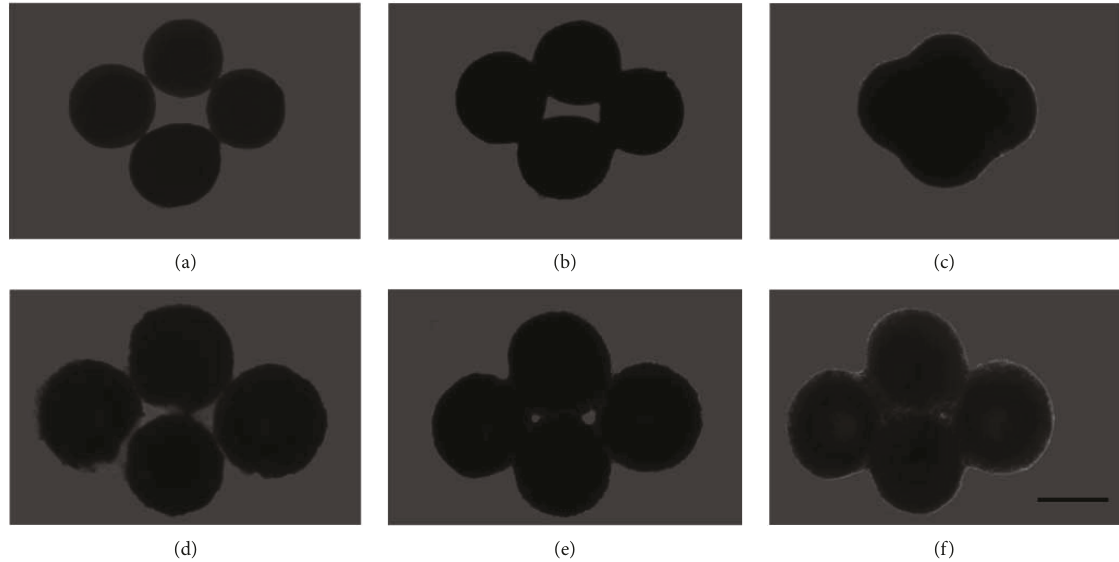
Figure 7: The CPC spheroids retained their fusion capacity even after spontaneous chondrogenesis. The CPC spheroids maintained for 2 days (a – c) and 21 days (d – f) in cell spheroid culture retained their fusion capacity. The CPC spheroids in close contact after 1 hour (a, d), 1 day (b, e) and 7 days (c, f). Note a complete fusion in c. Phase contrast microscopy. Bar size: 400 μ